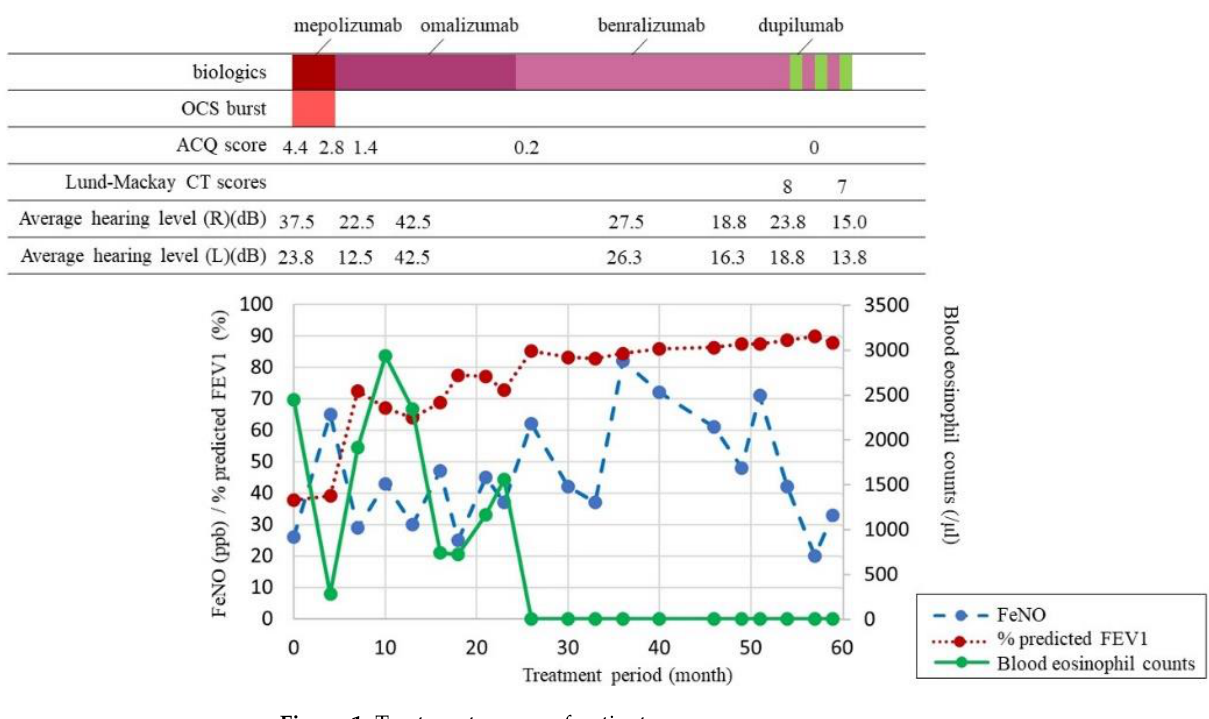
Figure 1. Treatment course of patient.